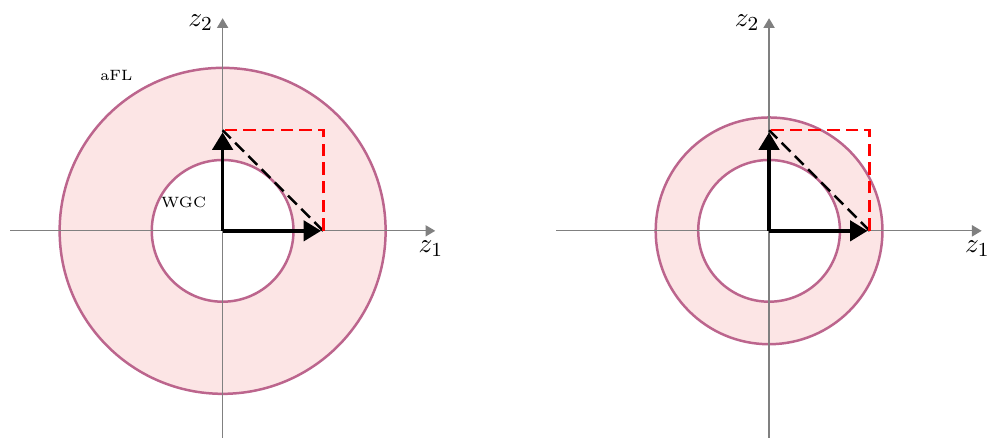
Figure 1. Convex shell: allowed axionic states should lay inside the red area, between the inner (WGC) and the outer (aFL) circle. On the left, the charge vectors satisfy both conjectures, while on the right we have a violation of the aFL bound. Indeed, charge vectors need to be big enough for all extremal dyonic black holes (inner circle) to decay, so that the black dotted line lies outside the circle. If we also impose aFL and in a situation where the outer shell is very thin, having very big charge vectors could violate the aFL bound. In the right-hand side plot, the basis charge vectors barely satisfy aFL while the (1 , 1) charge vector violates